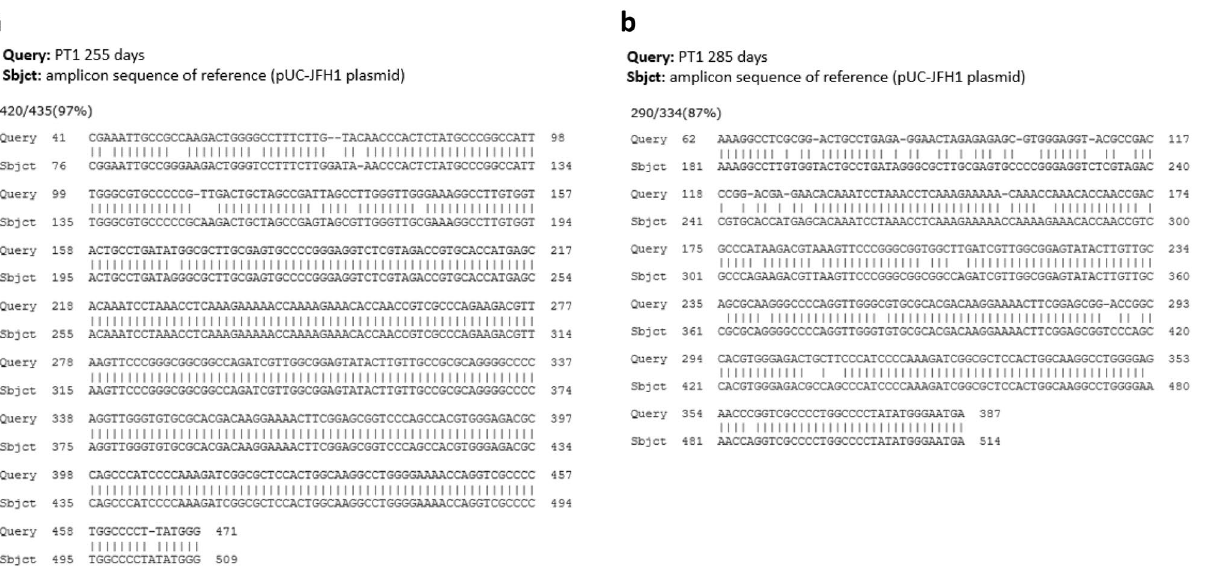
Figure 4. Sequence alignment of PCR fragments from a representative sample (PT1) at 255 days ( a ) or 285 days ( b ) of storage in 903 Protein Saver cards at RT